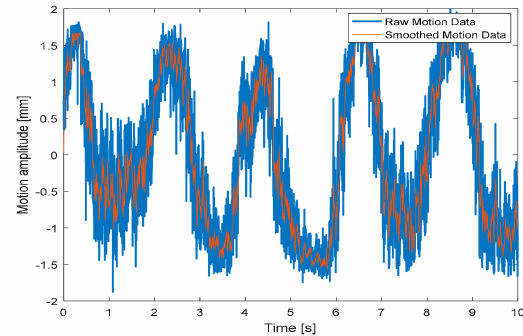
Figure 7. Detected movement ( x(t ) ) under normal breath.